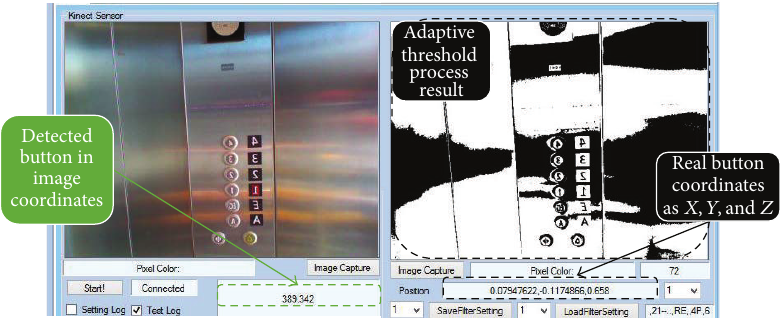
Figure 19: Elevator handler for internal buttons.